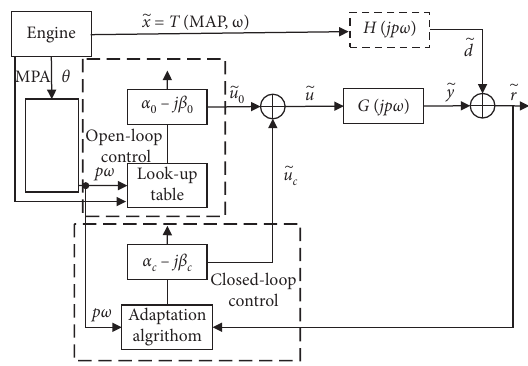
Figure 21: Frequency domain of the 2DOF control system